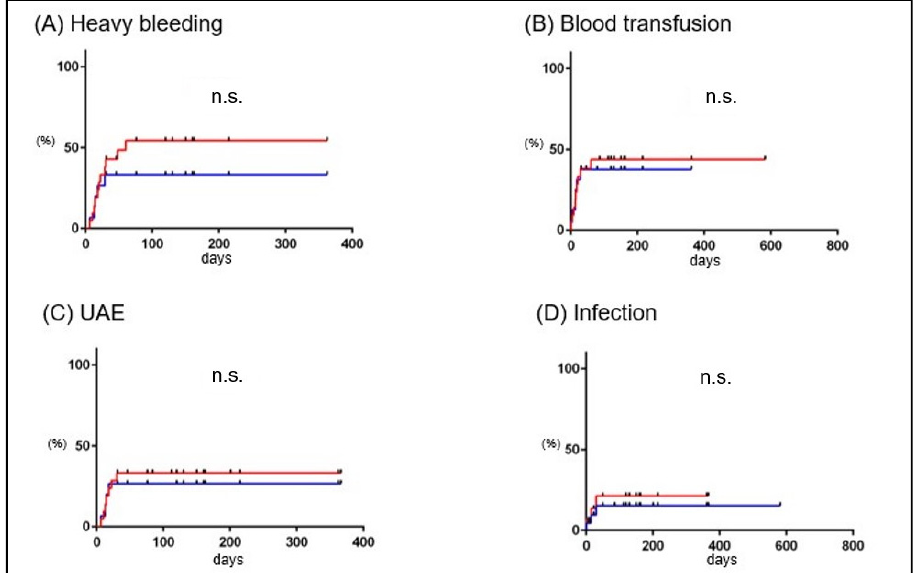
Figure 4. The cumulative incidence rate of events in group C (RPOC cases with conservative management). The horizontal and vertical axes represent the duration from delivery to the onset of the events (days) and the incidence rate (%), respectively. Red lines and blue lines show cumulative incidence rates of heavy bleeding ( A ), blood transfusion ( B ), UAE ( C ), and infection ( D ) in 22 cases with conservative management of RPOC and in 16 cases without placental extraction trial during conservative management. RPOC: retained products of conception; UAE: uterine artery emboliza-